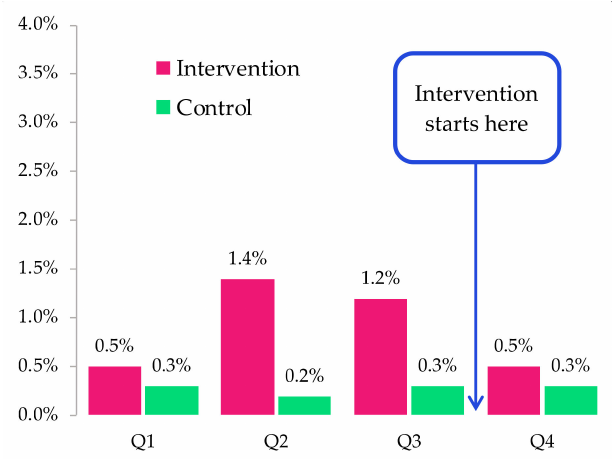
Figure 3. Average number of visits missed by ≥ 29-day per patient in 2022 by intervention OI/ART and